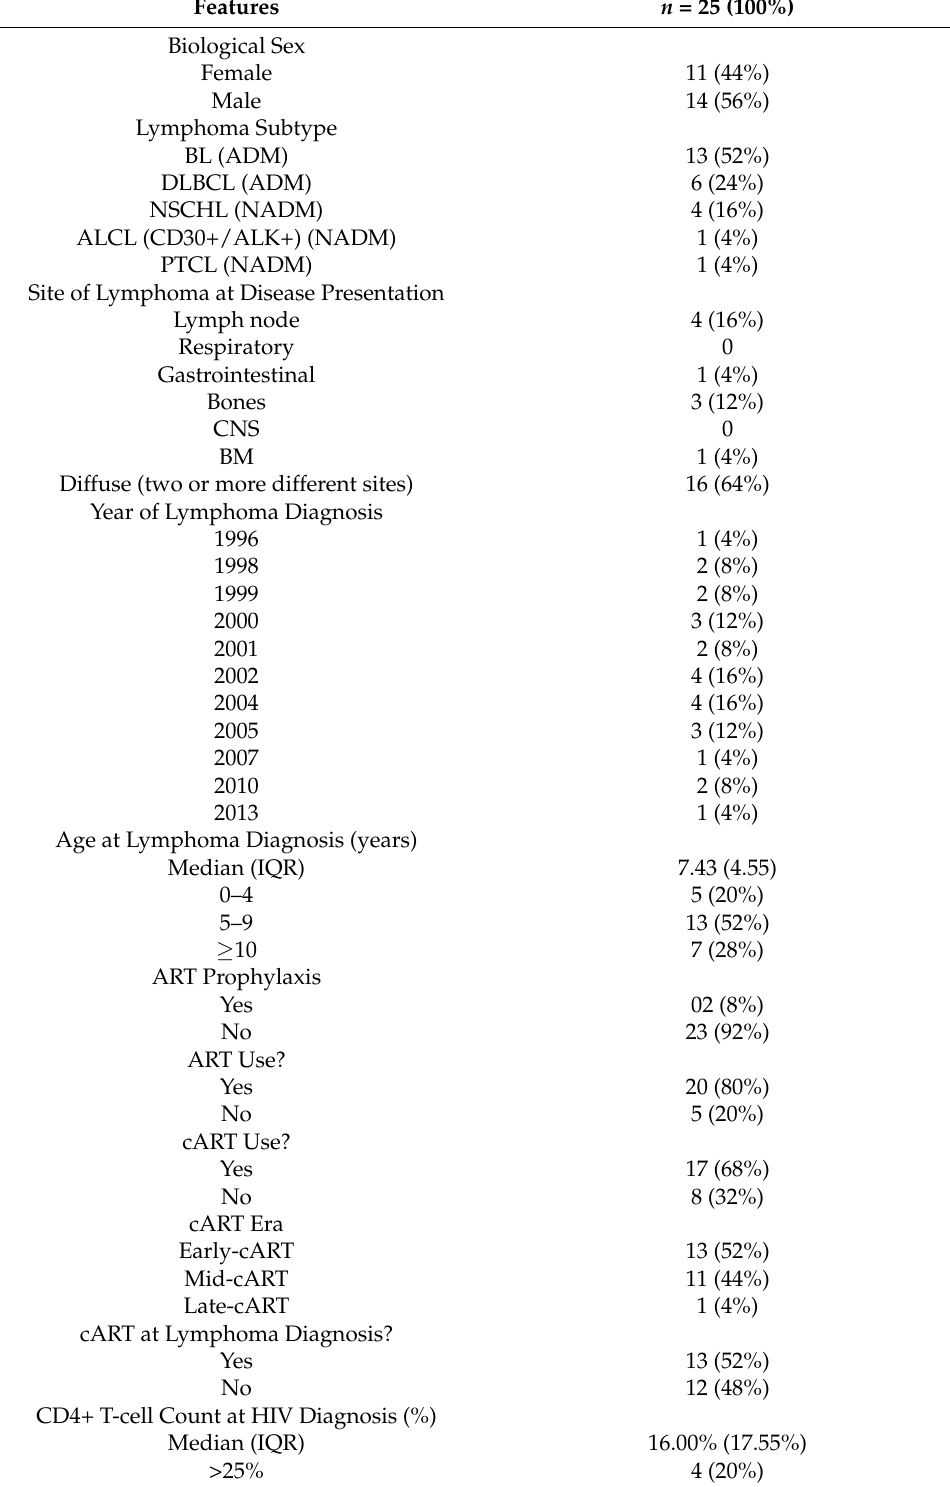
Table 1. Population